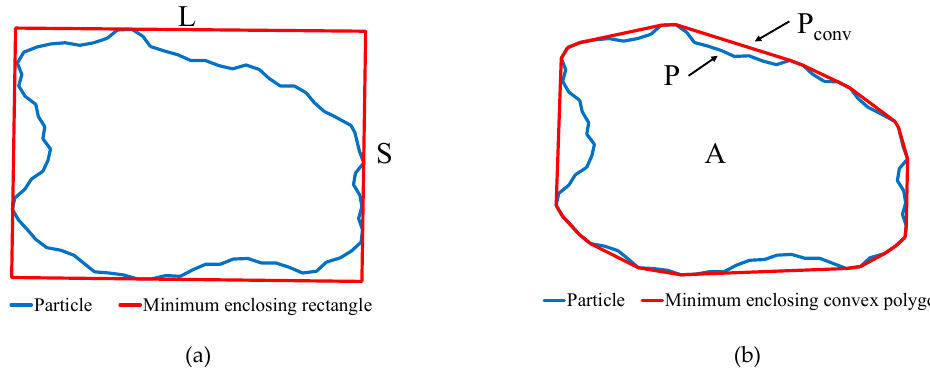
Figure 4. Schematic diagram of shape descriptors: EI, RI, and RE: ( a ) Diagram of the EI; ( b ) Diagram of the RI and RE.